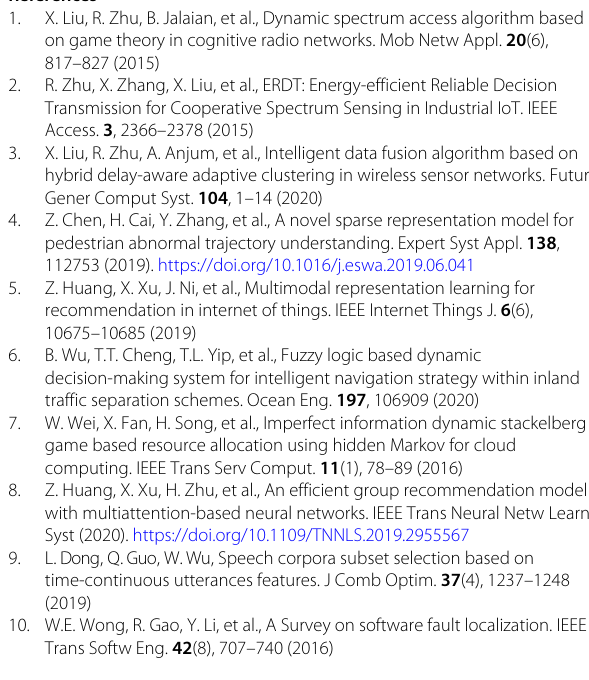
Conclusion A fault localization method based on sample programs by analyzing failure propagation is proposed. The